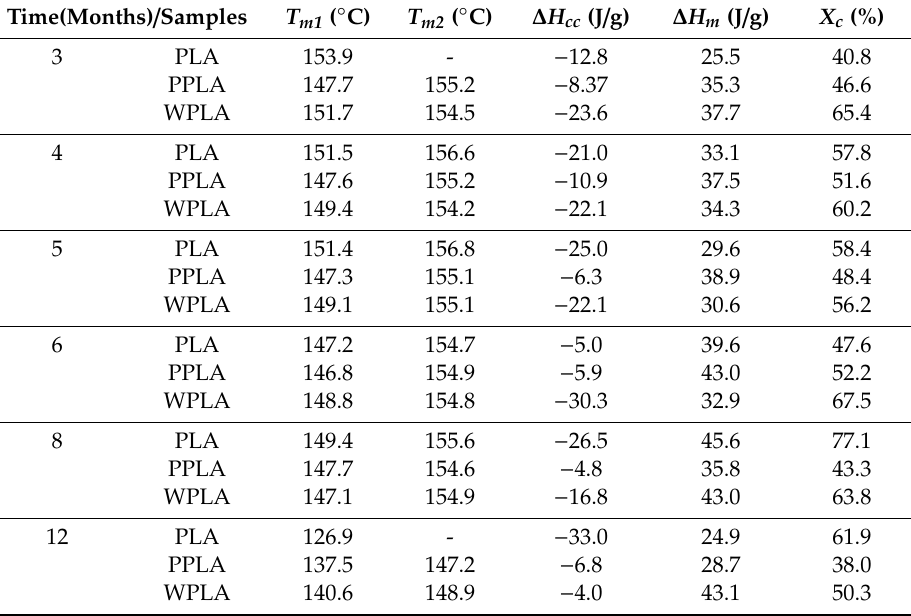
Figure 4. The differential scanning calorimetry (DSC) curves of the secondary heating curves obtained for the degraded samples. Table 3. DSC data corresponding to the samples.